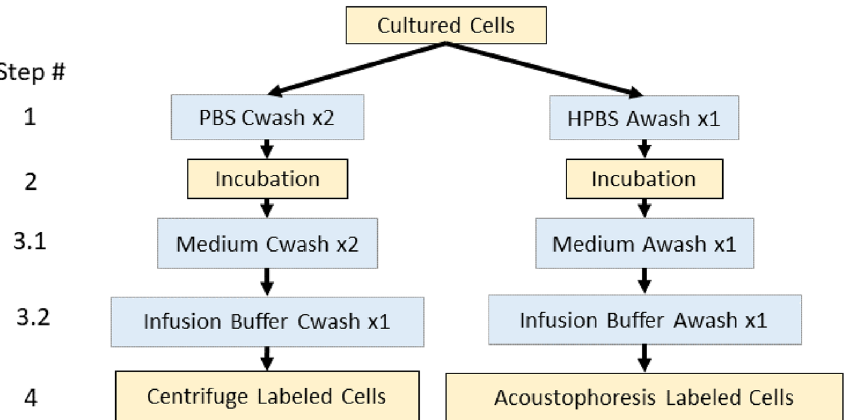
Figure 1. Side by side flow charts of the centrifugation and acoustophoresis cell washing methods. Cultured cells were split into two groups, one labeled using the control centrifugal labeling process while the other labeled using the acoustophoresis process. The centrifuge and acoustophoresis labeling processes were performed concurrently, side-by-side, to provide a best comparison test procedure. The steps in blue are the cell